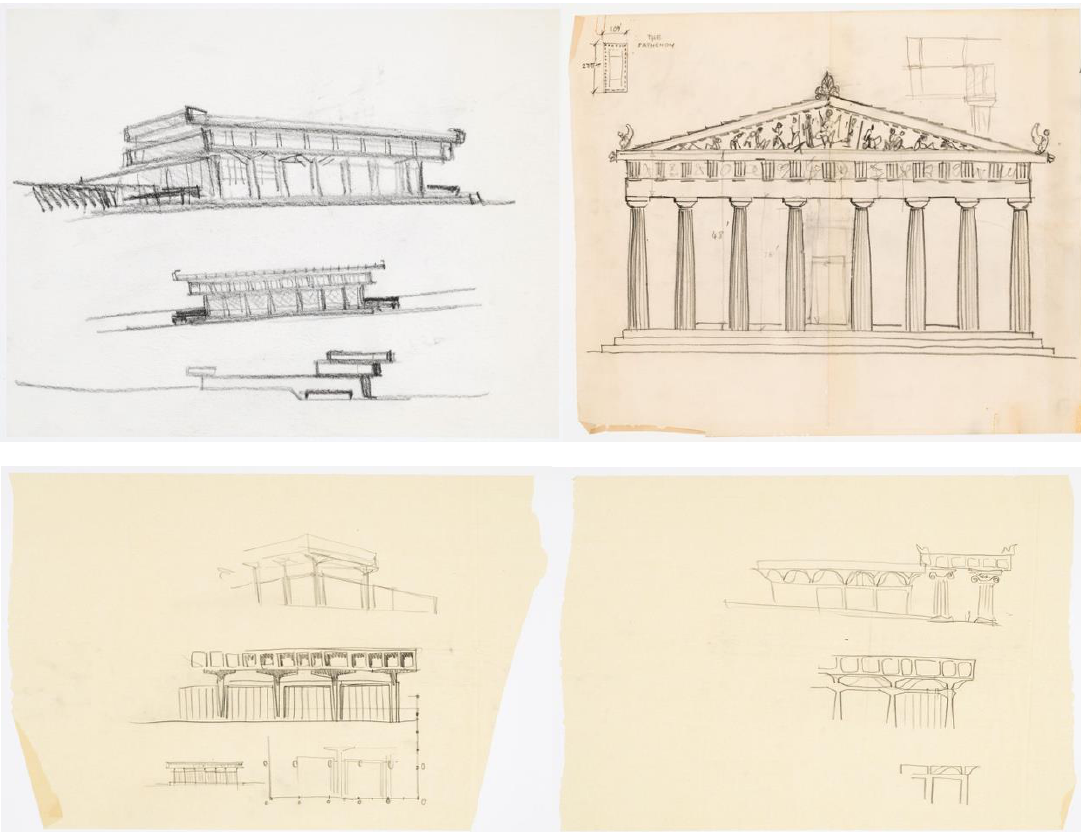
Figure 4. Eero Saarinen, conceptual sketches for Athens Airport, 1960, graphite on tracing paper, Canadian Centre for Architecture, Montréal, gift of David Graham Powrie. From top left to bottom right: Conceptual Perspective, Elevation and Section Sketches; Elevation with Plan of the Parthenon; Conceptual Perspective, Elevation and Plan Sketches; Conceptual Elevation Sketches.